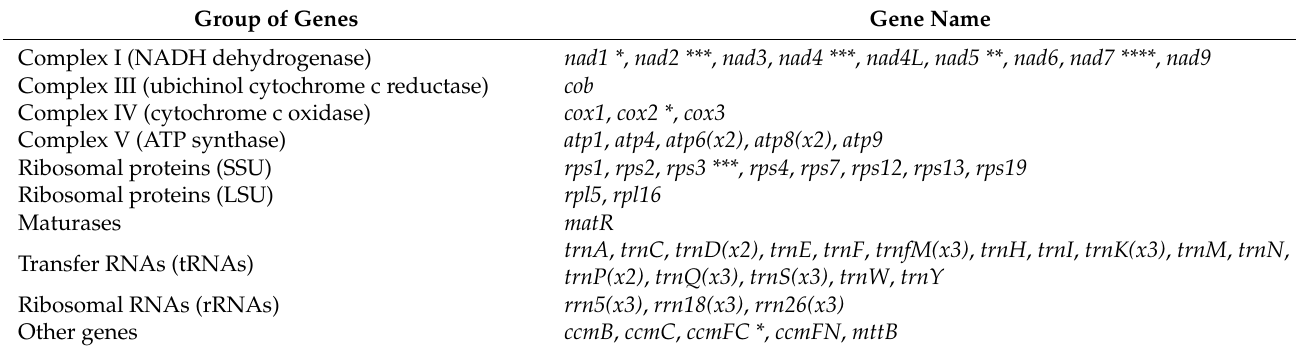
Table 2. Genomic contents of B and YS9